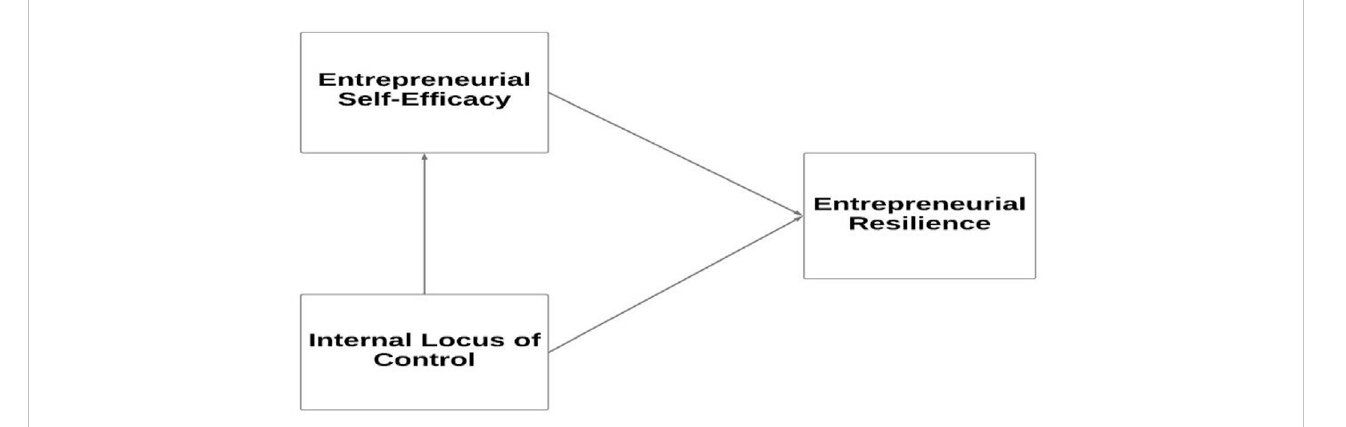
Proposed model of the study. Source: Authors ’